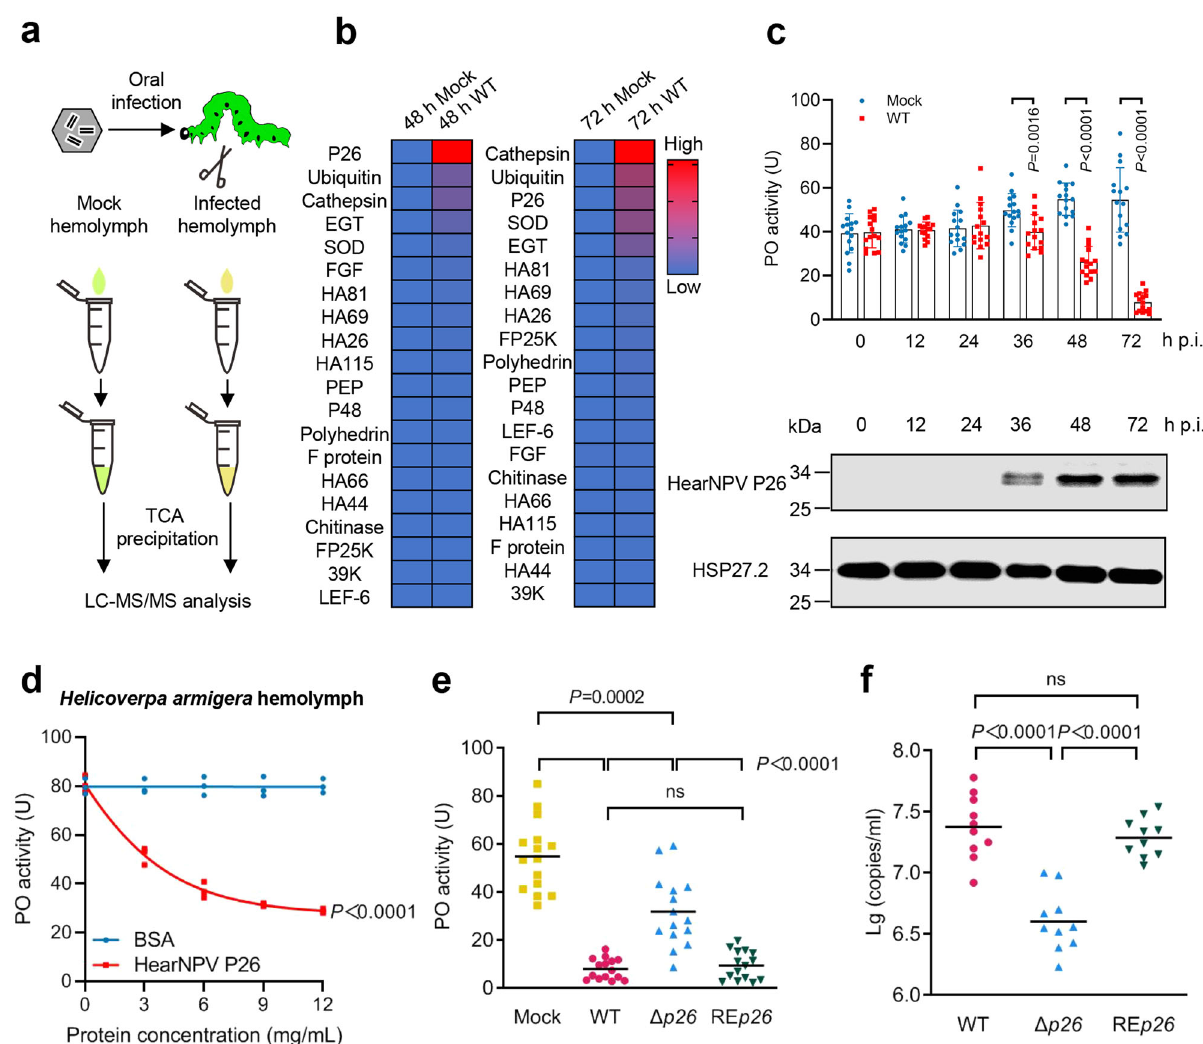
Fig. 2 | HearNPVP26inhibitstheprophenoloxidase(PPO)activation. a Scheme of mass spectrometry of hemolymph proteins from HearNPV-infected and mock- infected H. armigera larvae. b Heatmap of differentially expressed viral proteins in the hemolymph at 48 and 72h p.i.. Values are expressed as mean±s.e.m of two independent experiments. c Time-course analyses of PO activity and P26 expres- sion in the hemolymph of H. armigera . The dots represent individual H. armigera , and the bars indicate the mean±s.e.m values of each group ( n =15). Statistical signi fi cance of differences between Mock-infected and WT HearNPV-infected was evaluatedviatwo-tailedstudent ’ s t test,0hp.i.: P =0.89,12hp.i.: P =0.88,24hp.i.: P =0.73,36hp.i.: P =0.0016,48hp.i.: P <0.0001,72hp.i.: P <0.0001.Upperpanel: comparison of PO activities in hemolymph samples from mock-infected and virus- infected H. armigera at the indicated time points. Lower panel: Western blot ana- lysis of the P26 expression pro fi le in the hemolymph collected at the same time points post infection. HSP27.2 15 was used as loading control. d Concentration- dependent inhibition of hemolymph melanization by P26 proteins in vitro. Hemolymph (1 μ L) from naïve third instar larvae, mixed with different amounts of P26 (0 – 12mg/mL), was incubated on ice for 40min before measuring PO